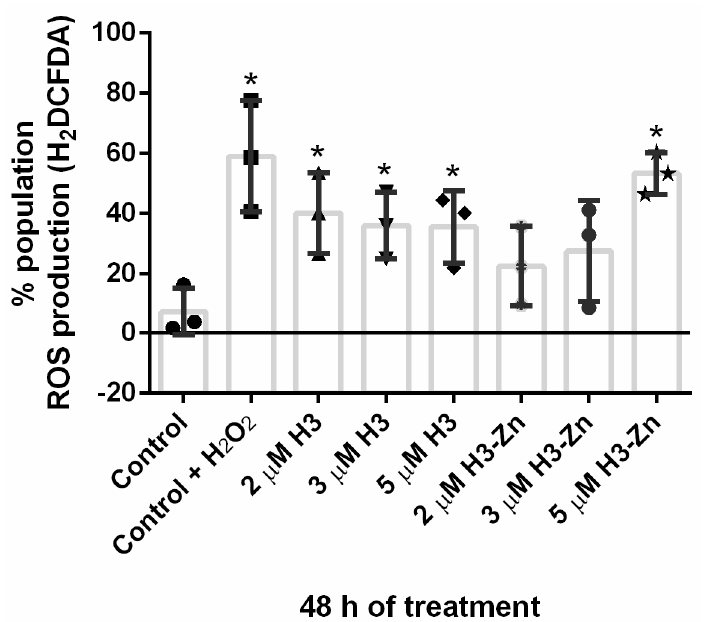
Figure 8. ROS production was measured in control and treated L. amazonensis promastigotes. Both cells were incubated with H 2 DCFDA, and the fluorescence intensity was measured in a microplate reader. The experiments were performed three times in triplicate, and the figure shown is representative of these experiments. One-way ANOVA with Dunnett’s post hoc test was used for statistical analysis. * p < 0.05.